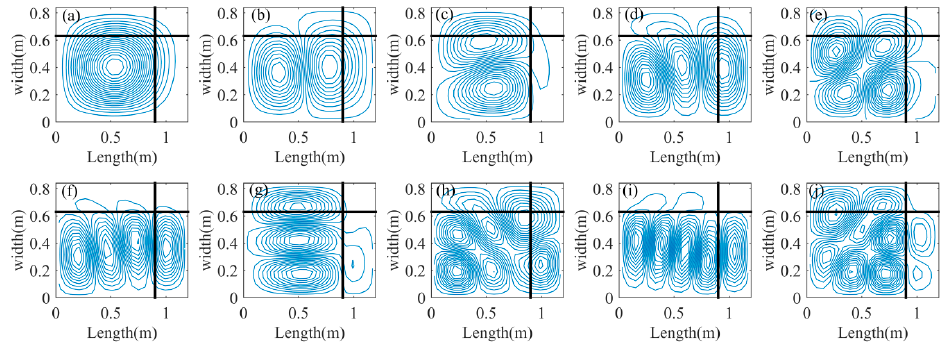
Figure 4. The mode shape of the modes of the ribbed plate B (( a – e ) for the first five modes, and ( f – j ), for the modes from the sixth to tenth).